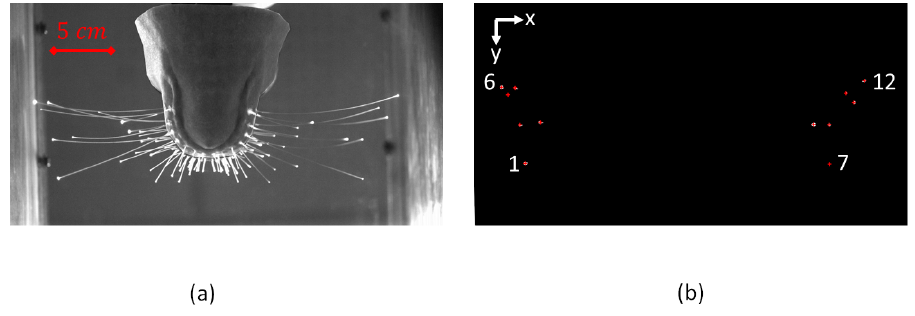
Figure 3. Camera views of the two recording modes: ( a ) grey-level compressed mode. ( b ) binary mode with centroid calculation. The grey-level image is masked before binarization so that only the 12 whiskers’ tips of interest are visible. The whiskers are numbered from 1 to 12 such that whiskers no. 1, 6, 7 and 12 indicate the front-left, rear-left, front-right and rear-right whiskers